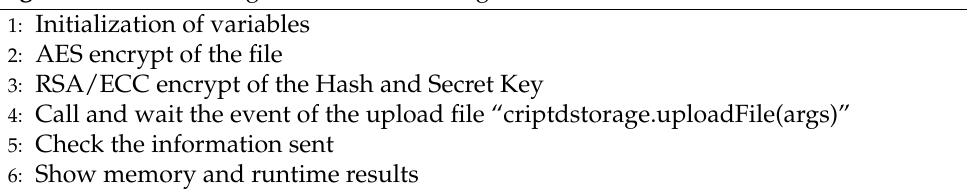
Algorithm 1 Test file algorithm of submitting a